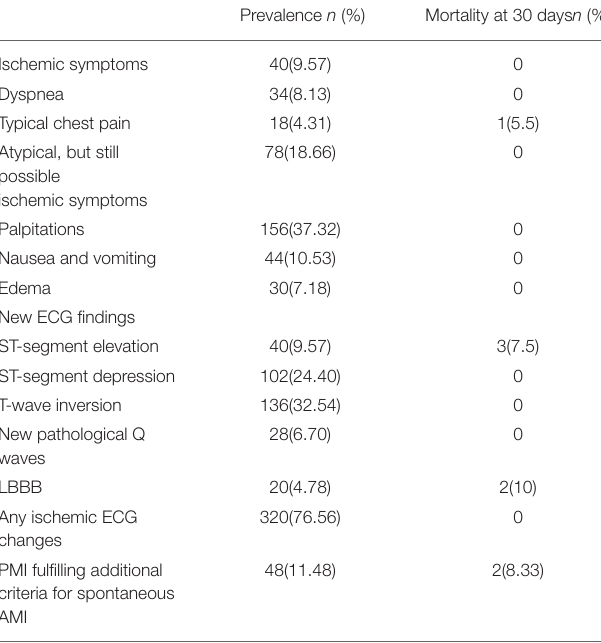
TABLE 2 | Clinical presentation, ECG changes within 7 days in patients experiencing a postoperative myocardial injury (PMI).